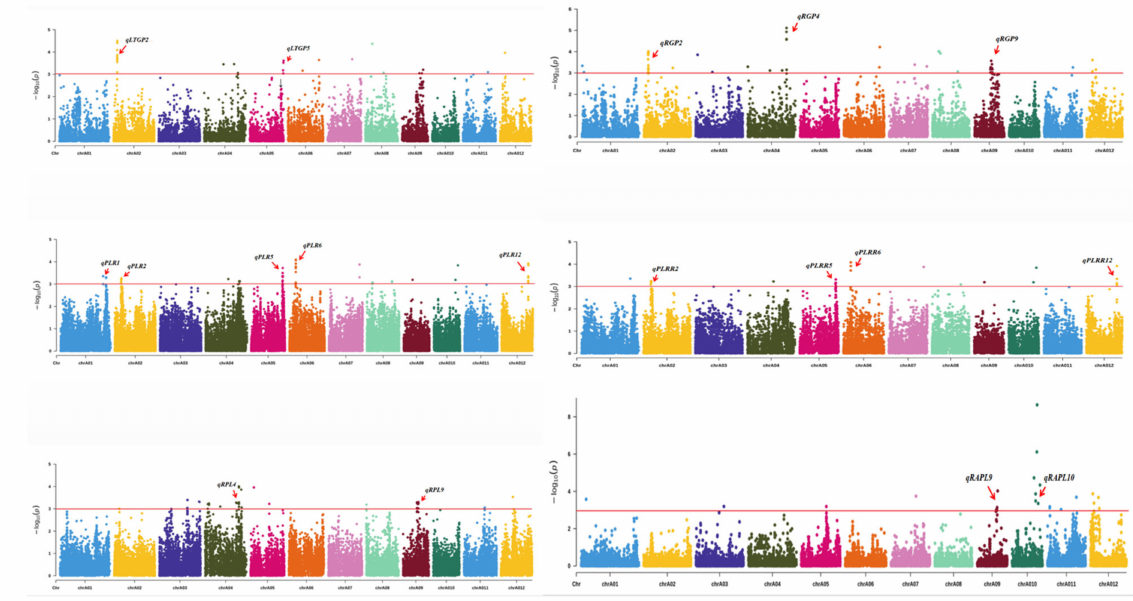
Figure 5. Manhattan plots of GWAS for six LTG indices. The vertical axis in each subfigures represents the value of -log 10 ( P ), and the horizontal axis represents 12 chromosomes in rice, the solid red line represents when P value equals 0.001. The red arrow indicates QTLs detected from six